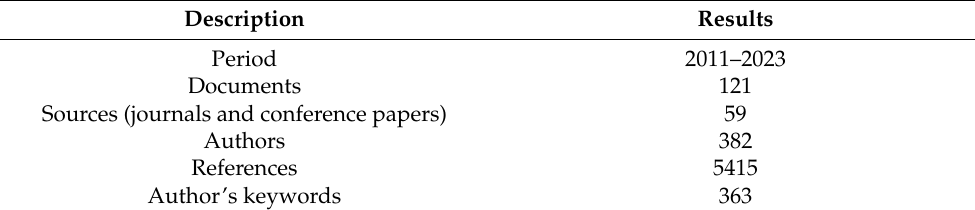
Table 1. Descriptive analysis: Main information regarding the